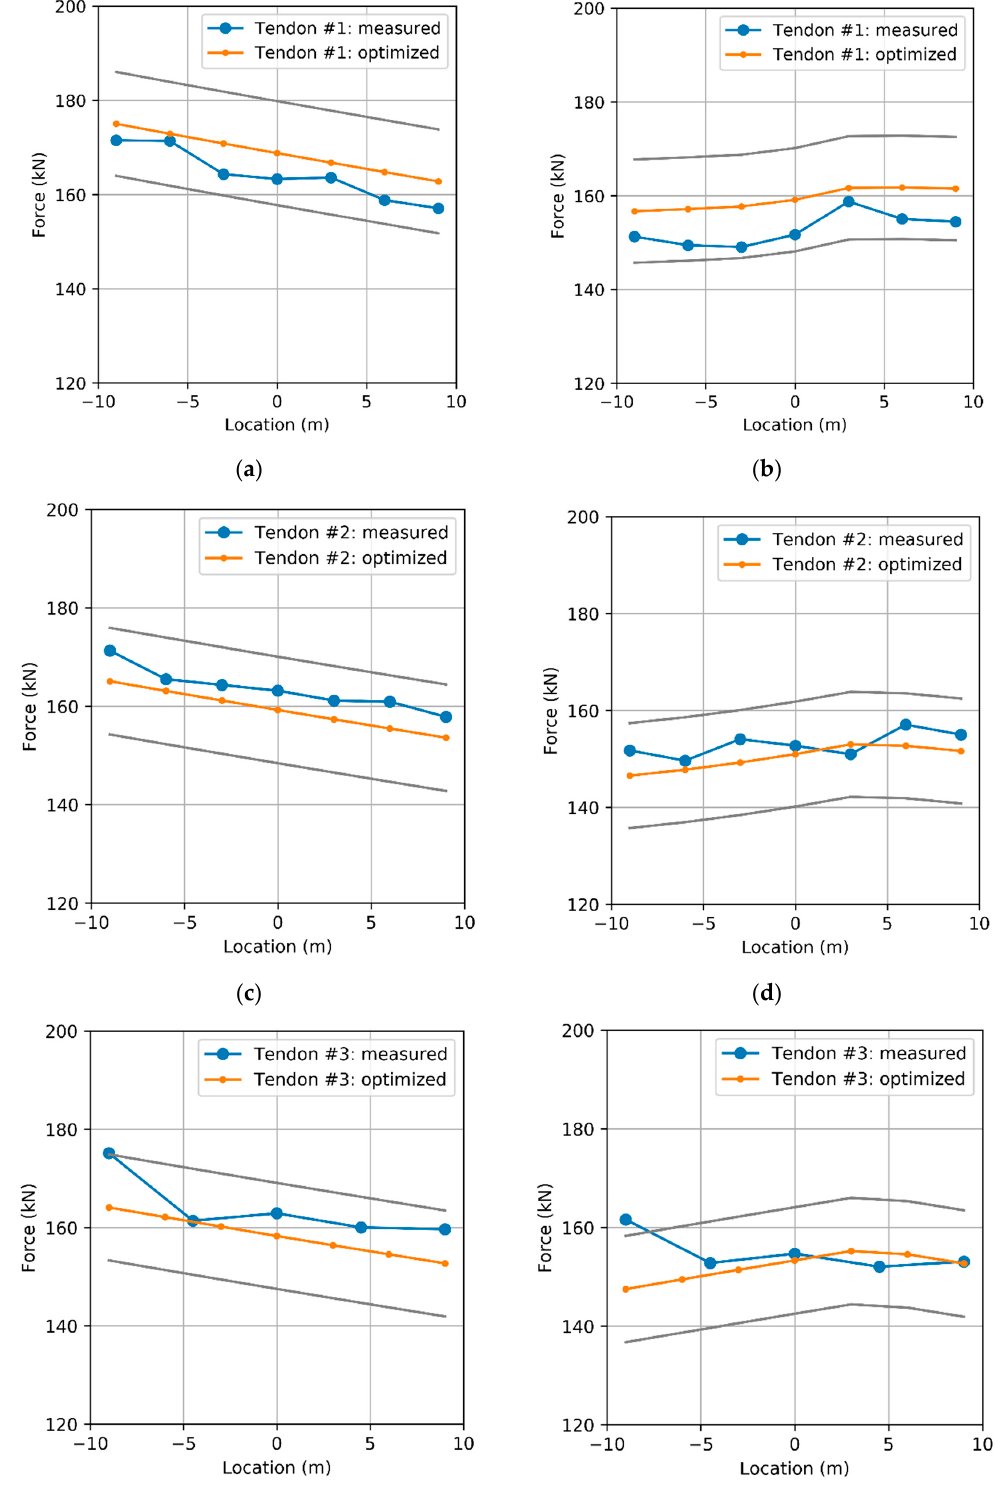
Figure 9. Comparison between experiment and optimization per jacking stage (gray lines represent 95% confidence interval): ( a ) Tendon #1: Jacking of Tendon #1; ( b ) Tendon #1: Setting of Tendon #3; ( c ) Tendon #2: Jacking of Tendon #2; ( d ) Tendon #2: Setting of Tendon #3; ( e ) Tendon #3: Jacking of Tendon #3; ( f ) Tendon #3: Setting of Tendon #3.